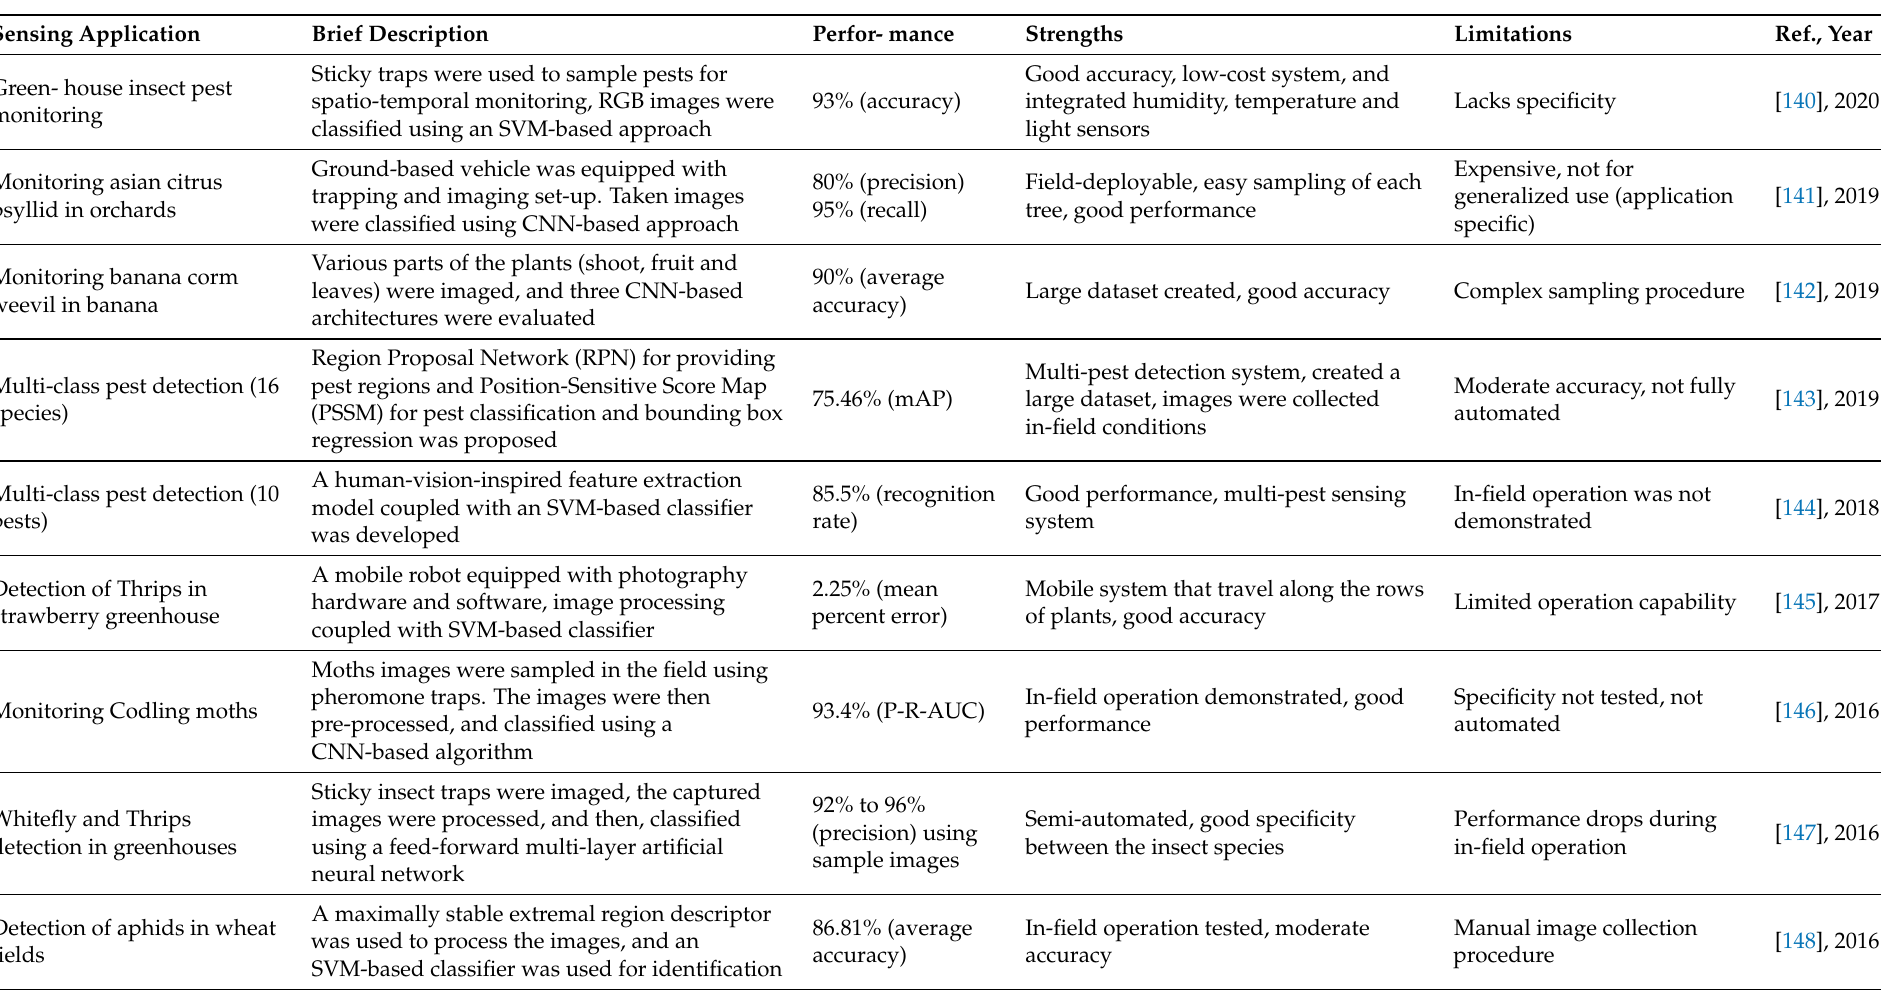
Table 5. A comparison of the key recent imaging-based sensing methods for herbivorous pest monitoring in